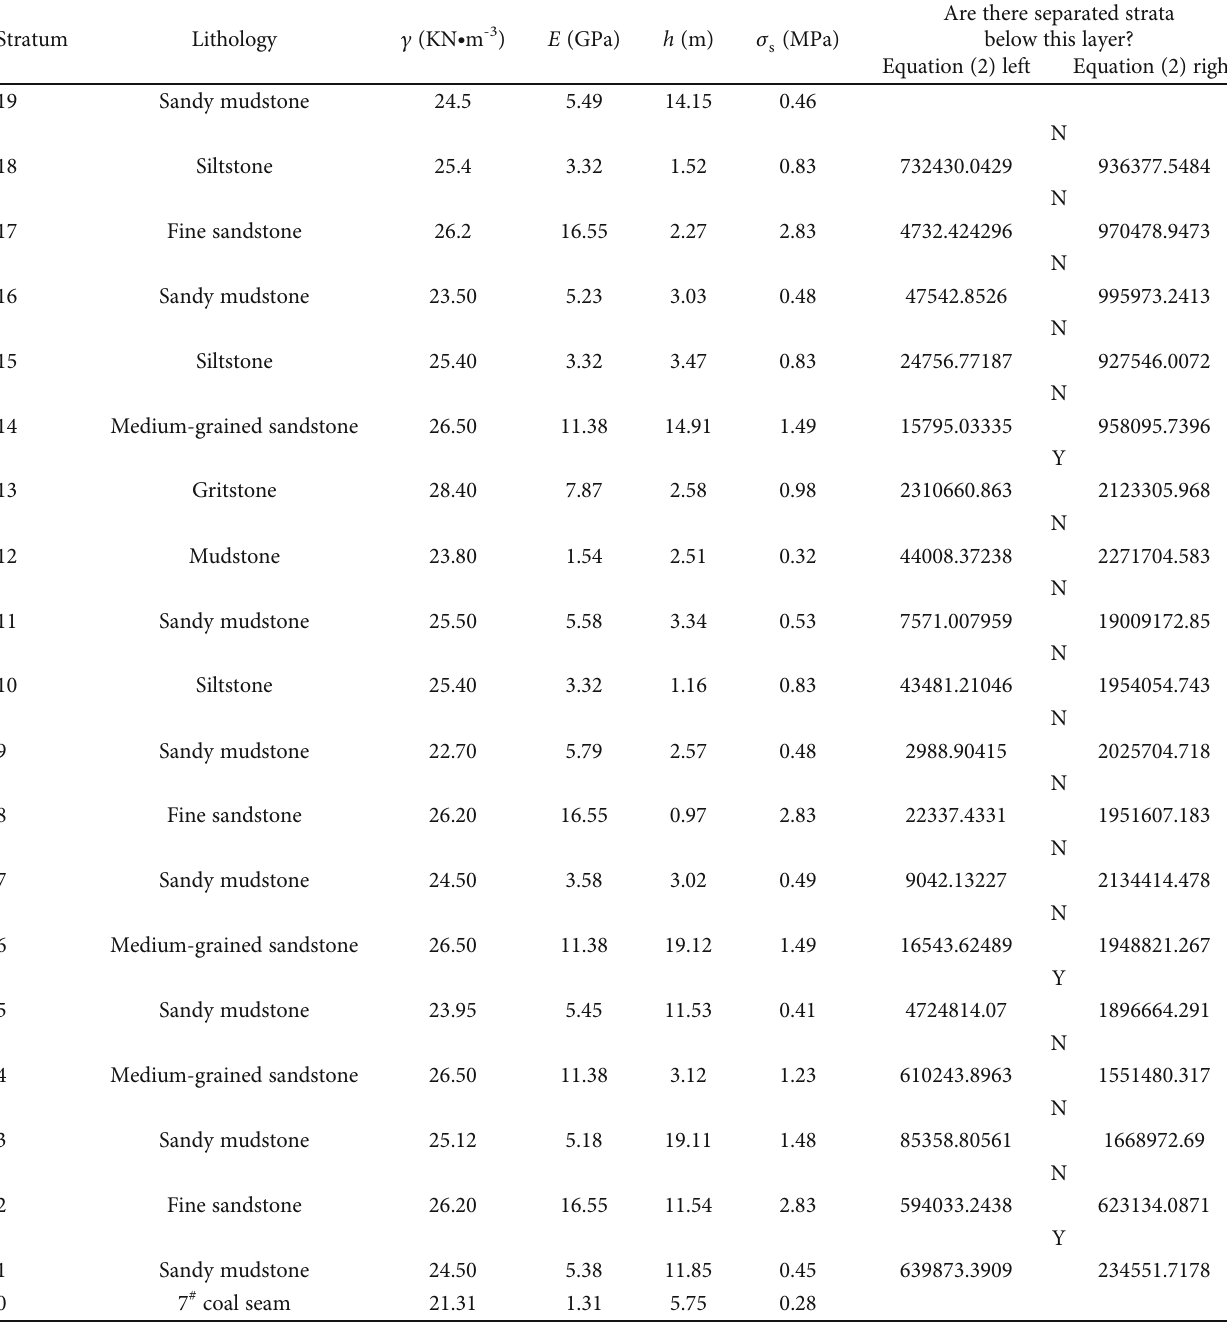
Table 1: Judgment results of the development position of the separation